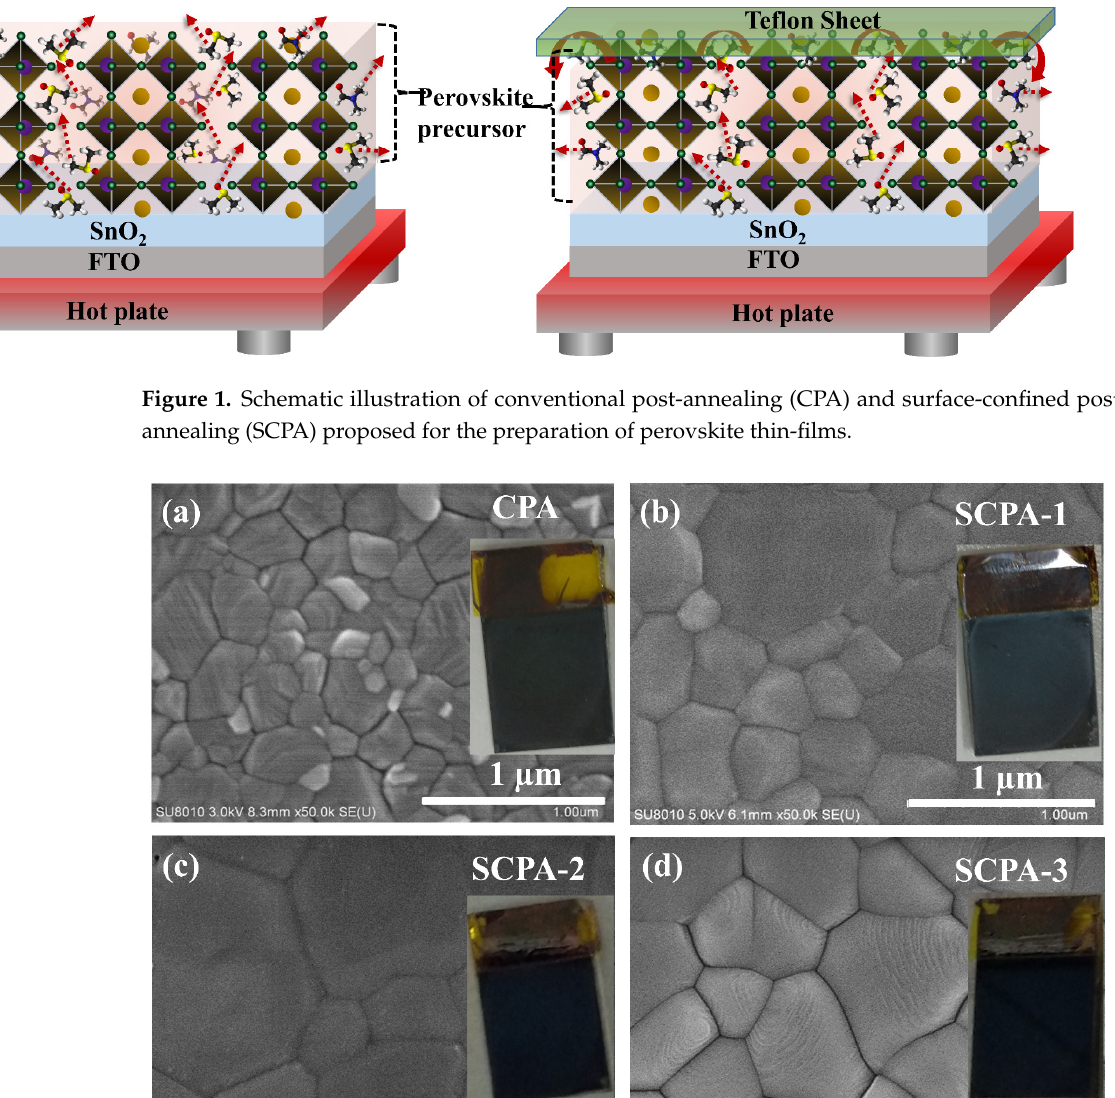
Figure 1. Schematic illustration of conventional post-annealing (CPA) and surface-confined post- annealing (SCPA) proposed for the preparation of perovskite thin-films.